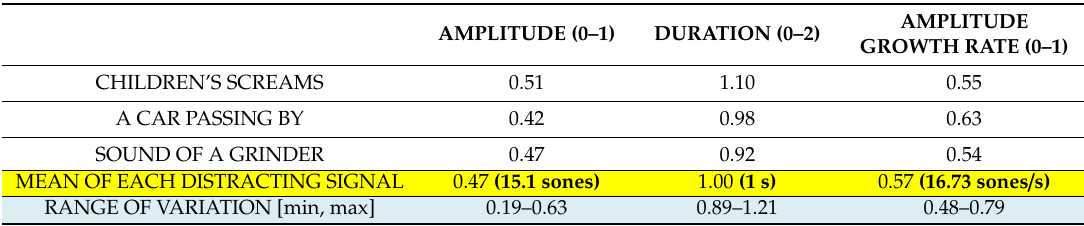
Table 1. Study results for the sound of the children’s screams, a car passing by and a grinder (number of study participants =